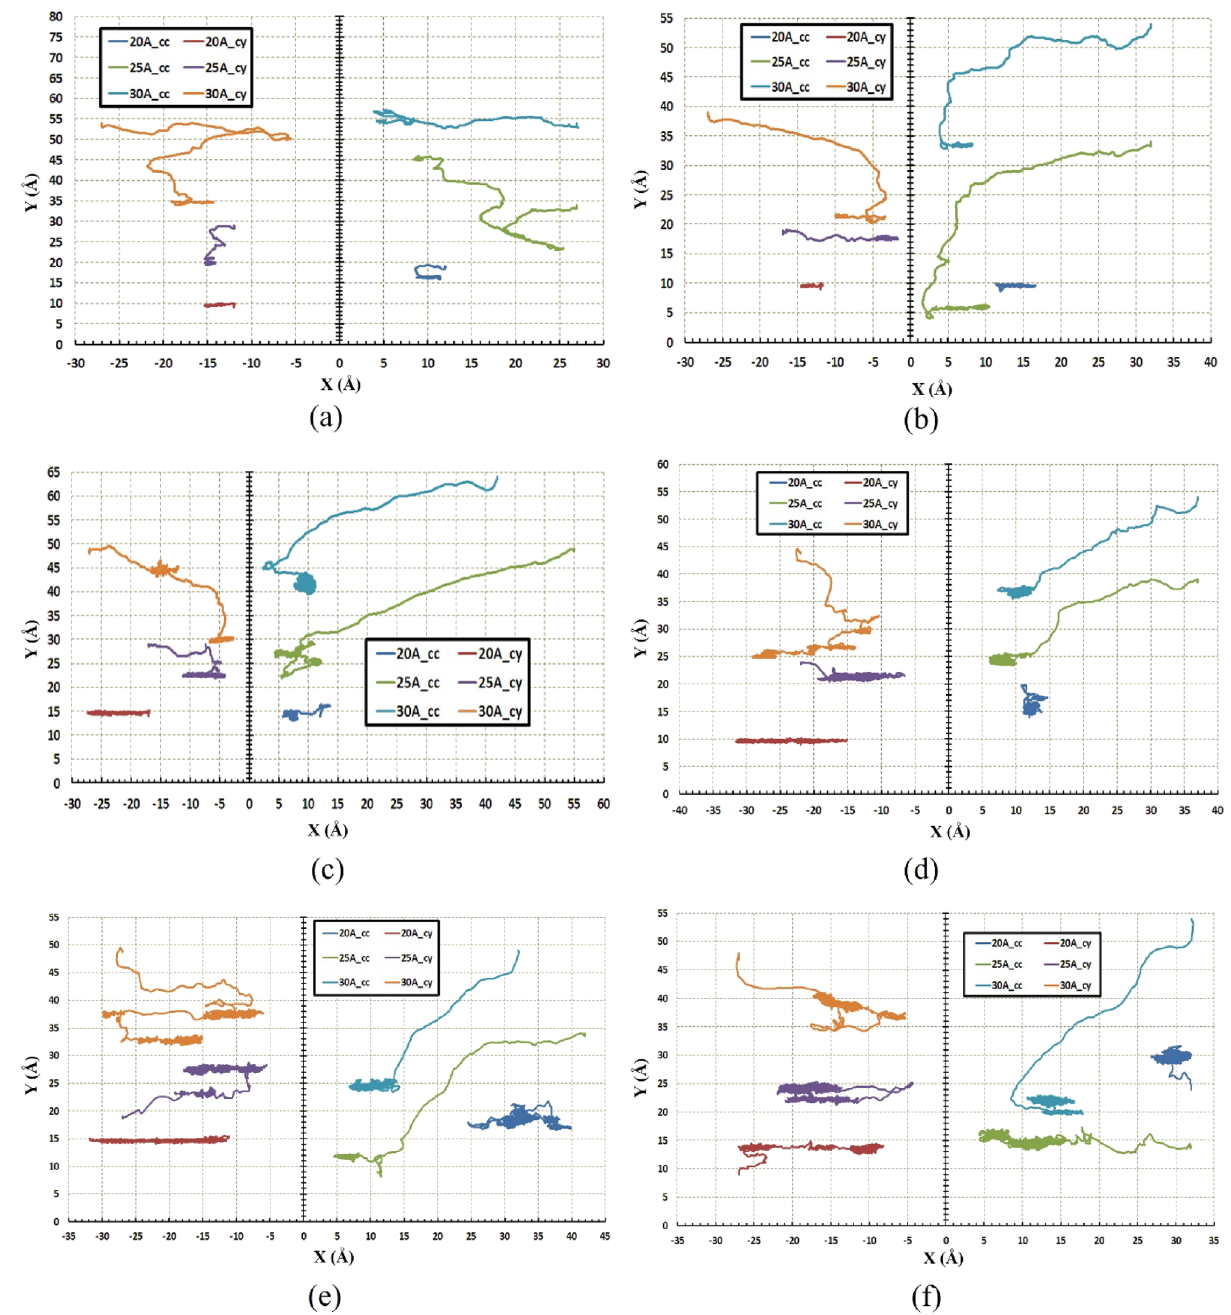
Figure 10. Trajectories of the nanocar on the concave (cc) and the cylindrical (cy) substrates during simulations ( a ) 75 K , ( b ) 150 K , ( c ) 300 K , ( d ) 400 K , ( e ) 500 K , and ( f ) 600 K . For the radius of 30 Å at both geometries and the radius of 25 Å at concave geometry, nanocar has long-range movement even at low temperatures like 75 K and 150 K